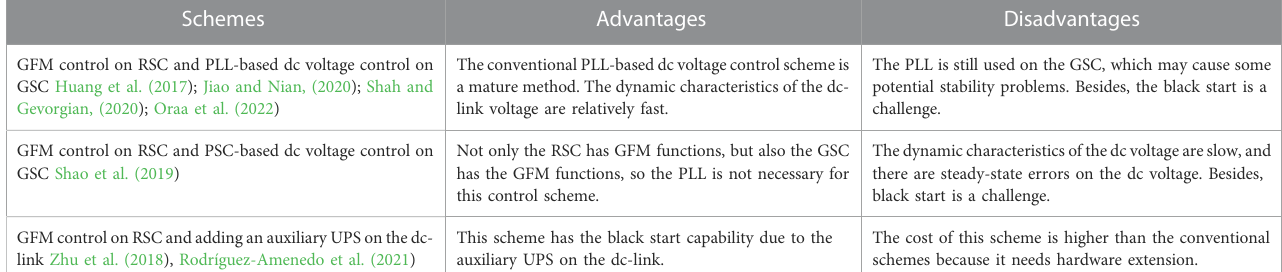
TABLE 2 Comparison of three dc-link voltage control schemes of type-3 wind generators. Schemes Advantages Disadvantages